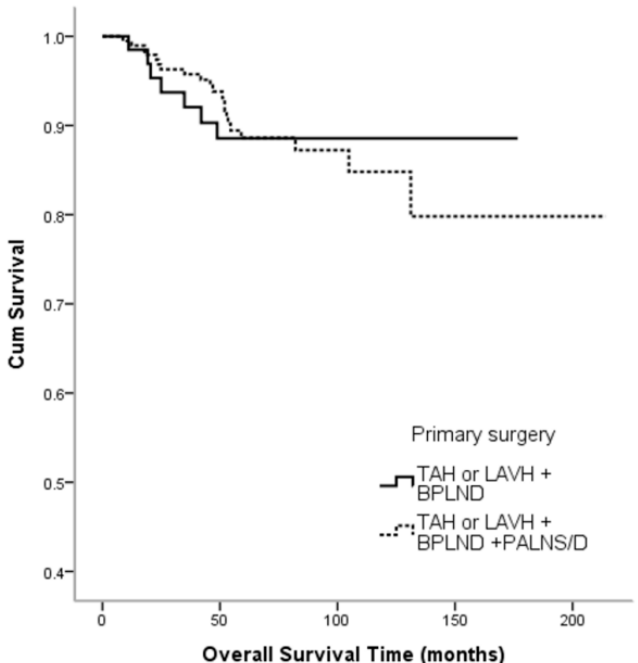
Figure 2. Kaplan-Meier survival estimates according to primary surgical types (log-rank: TAH or LAVH + BPLND vs. TAH or LAVH + BPLND + PALNS/D, p = 0.884). TAH: total abdominal hysterectomy; LAVH: laparoscopic-assisted vaginal hysterectomy; BPLND: bilateral pelvic lymph node dissection, PALNS/D: para-aortic lymph node sampling or dissection.